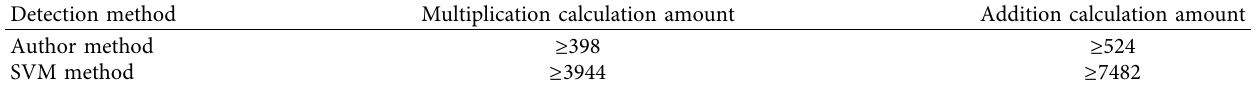
Table 1: Comparison of the calculation amount of the two detection methods.